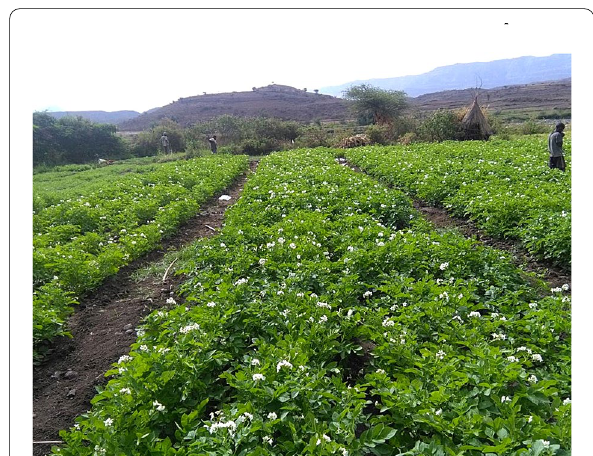
Fig. 2. Field performance of potato at Kechin